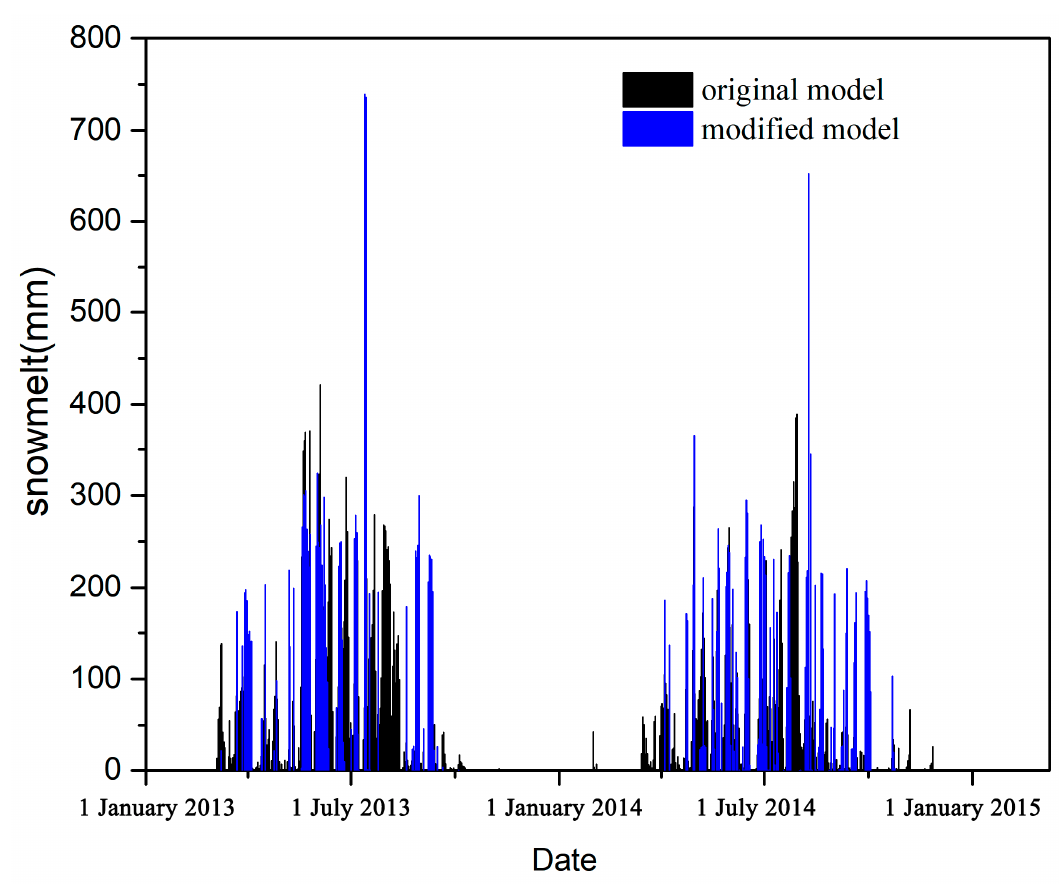
Figure 6. Comparison of calculated snowmelt volume from the original and modified model during the calibration and validation periods (2013 and 2014).